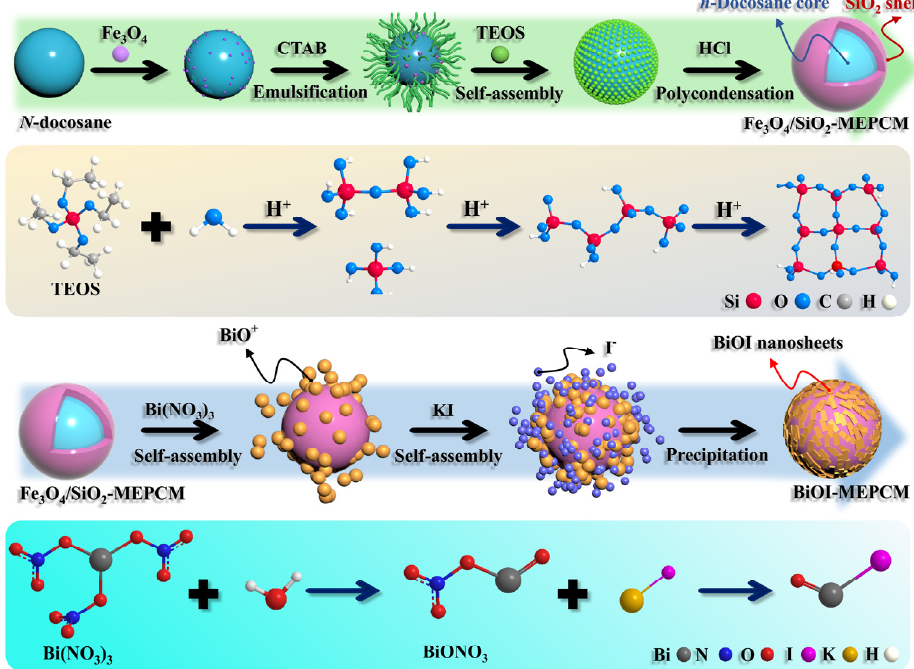
Figure 1. Scheme of synthetic procedure and reaction mechanism of BiOI-MEPCM.